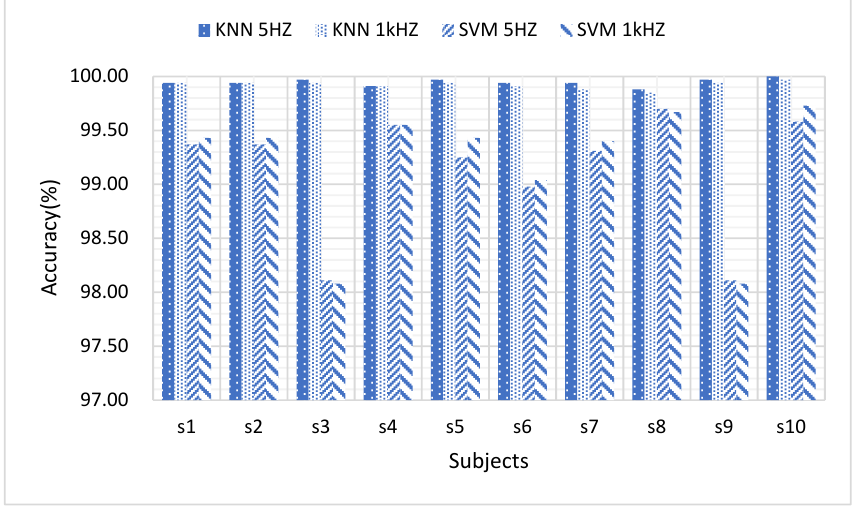
Figure 9. Comparison of classification accuracy of different subjects by KNN and SVM classifiers at sampling frequency of 1 kHz and 5 Hz.